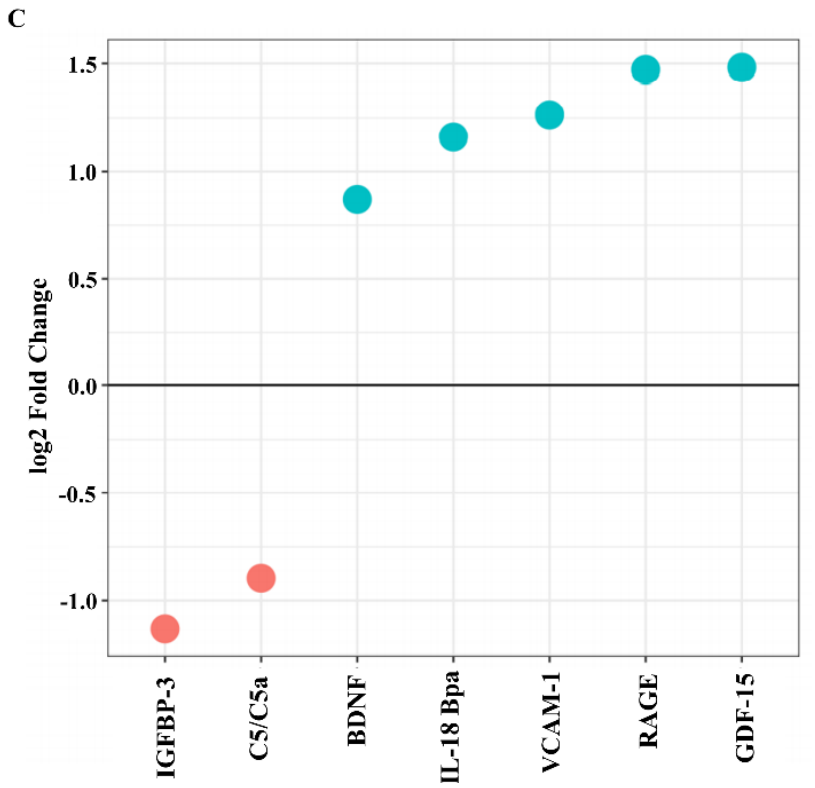
Figure 3. mRNA expression of cytokines and chemokines by SCAP modulated by oral bacteria. SCAP co-cultured in direct contact with ( A ) F. nucleatum , ( B ) F. nucleatum supernatants, and ( C ) E. faecalis with corresponding untreated control levels. Blue and red dots indicate upregulated and downregulated cytokines, respectively.